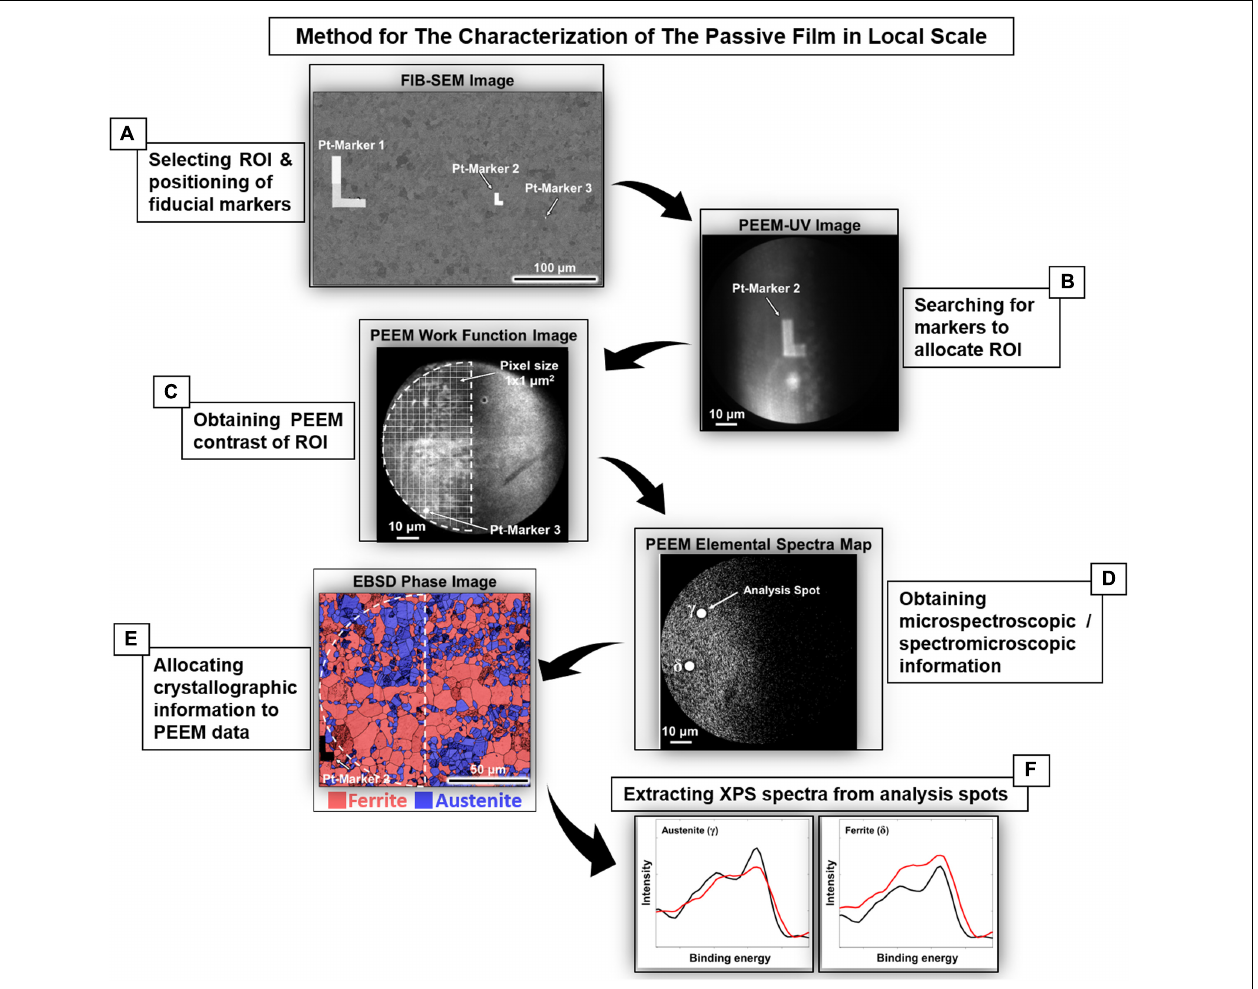
FIGURE 1 | Protocol of the procedures to access local spectroscopic information of 2507 DSS. (A) Fiducial Pt markers were deposited using FIB-SEM to select the region of interest (ROI). (B) ROI was located in UV mode for subsequent PEEM measurement. (C,D) The same ROI was imaged in photoemission mode and defined as the area for PEEM measurement. (E) The measured ROI was later re-accessed using EBSD to allocate the crystallographic information (phases, orientation, etc.). (F) The spectra obtained were then associated with the local microstructure as exemplified by the ferrite and austenite grains with (001) orientation before and after anodic polarization in 1M NaCl [reprint with permission (Långberg et al.,